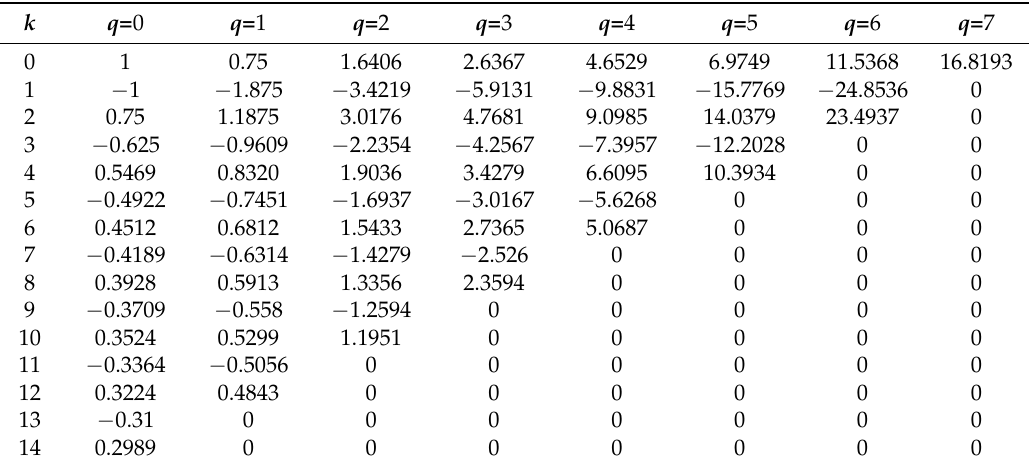
Table 1. b k , q coefficients of the isotropic orthogonal transfer algorithm (IOTA) filter.